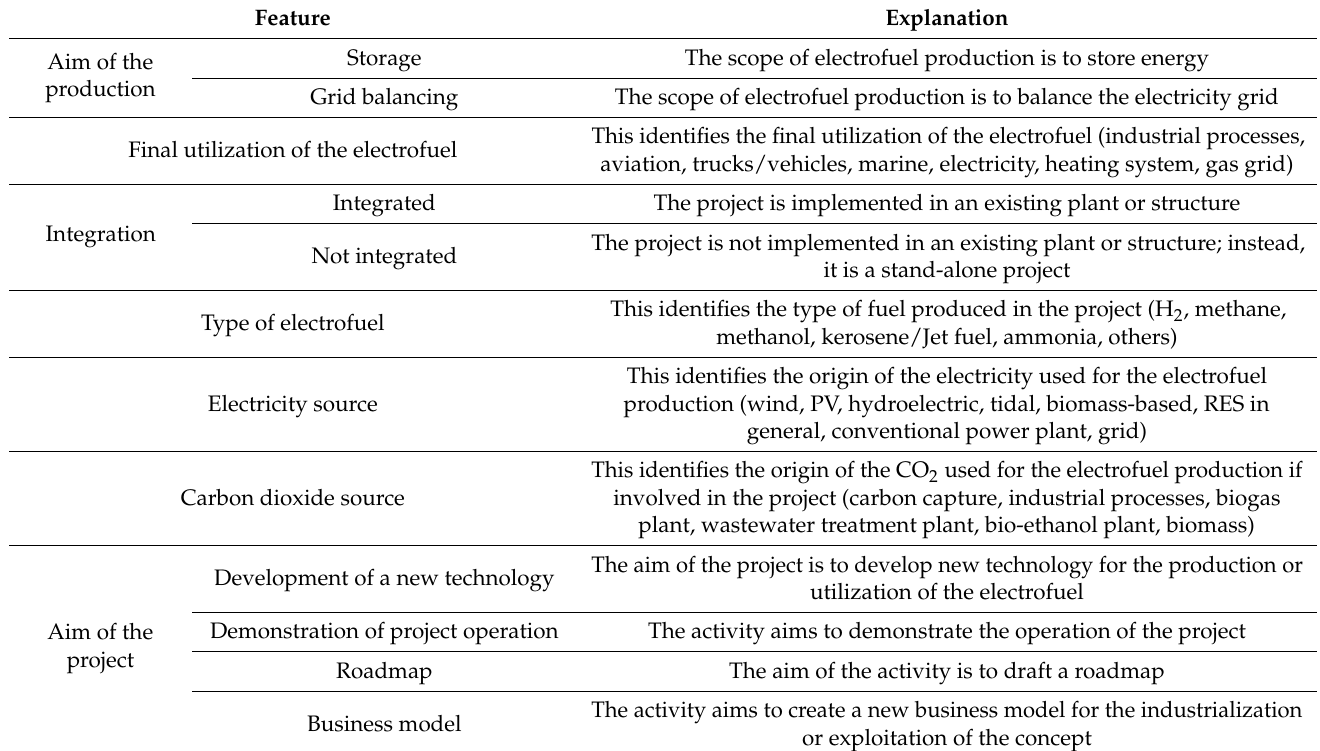
Table 2. Selected features for the characterization of the research and innovation projects on electro- fuel